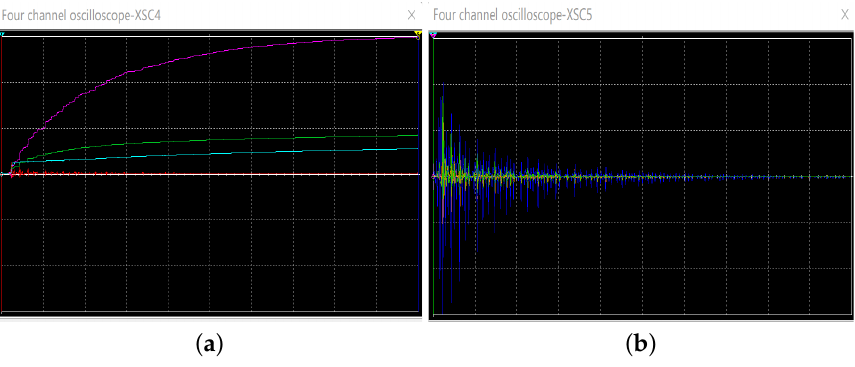
Figure 14. Identification of a 1 , b 1 , c 1 , and d 1 by an electronic